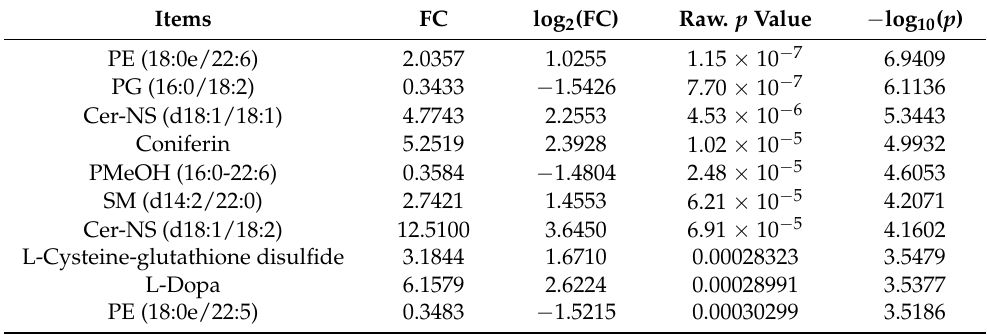
Table 3. Top 10 differential yolk metabolites identified between male and female chicken embryos at